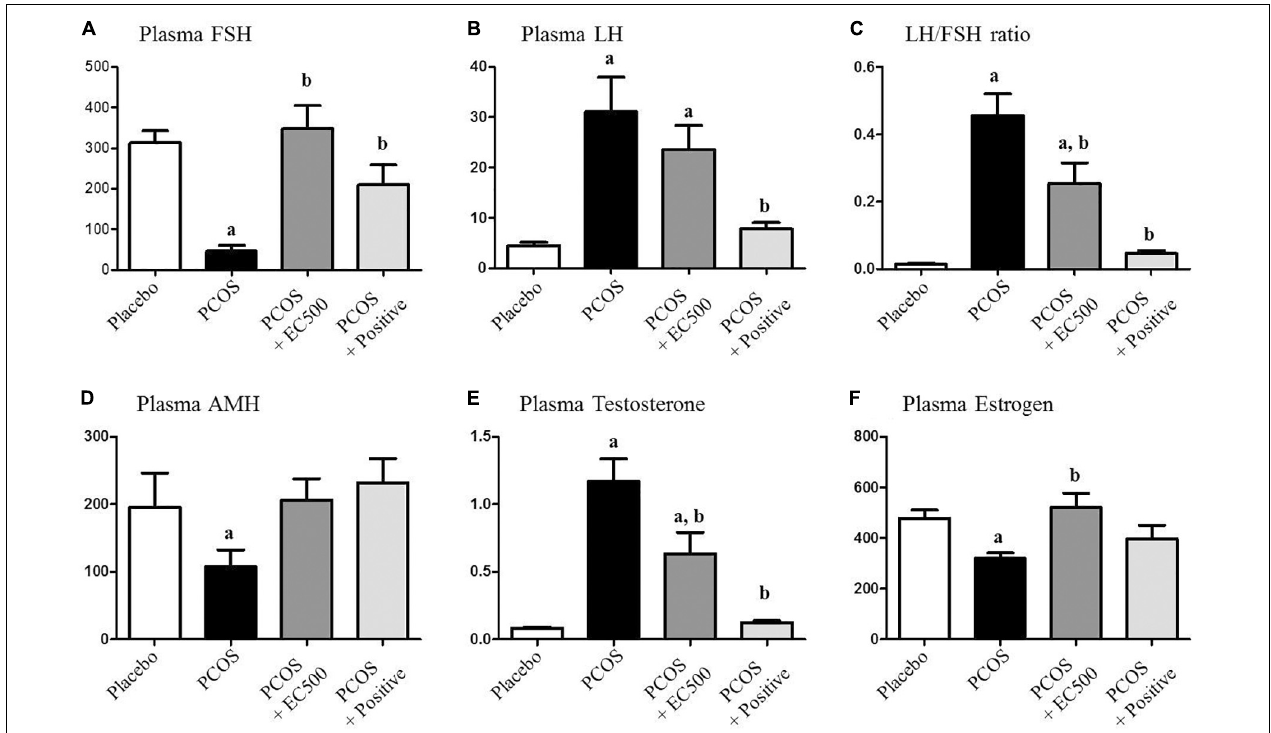
FIGURE 3 | Effect of E. cava extract on plasma hormonal levels. For PCOS experiments, 6-week-old female rats were administered letrozole pellets (0.1 mg/kg/day). After 2 weeks, E. cava extract was administered via P.O. treatment every day for 2 weeks. Levels of plasma steroid hormones, such as (A) FSH, (B) LH, (C) LH/FSH ratio, (D) AMH, (E) testosterone, and (F) estrogen, were measured using a competitive enzyme-linked immunosorbent assay (ELISA) kit. All values represent the means ± SEMs. a p < 0.05 vs. placebo group, b p < 0.05 vs. PCOS group. EC, E. cava extract; PCOS, polycystic ovary